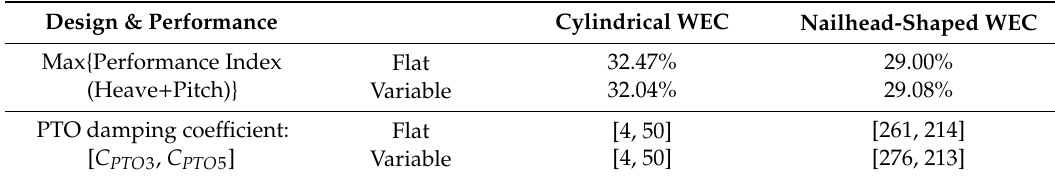
Table 3. Optimum WEC designs, P.I., and PTO damping for flat and variable bottom topography in the